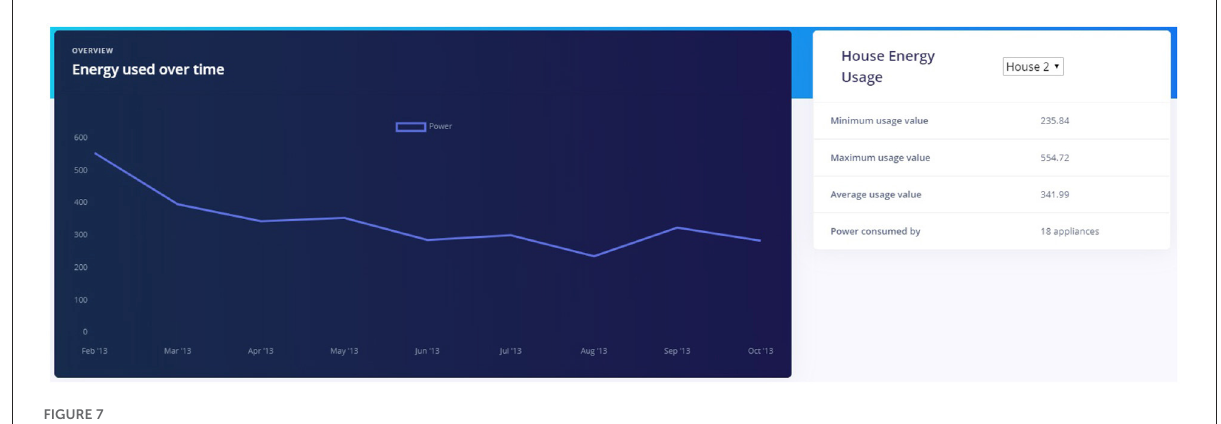
FIGURE7 Energy metrics for House